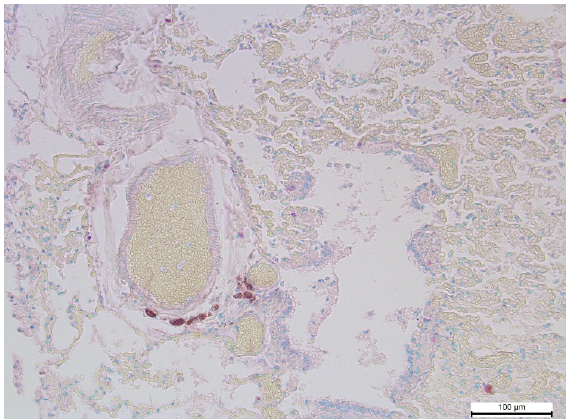
Fig. 13 B. Lungs. Single lymphocytes and macrophages in the lumen of the enlarged alveoli. Brache. EP 10, lens 20 A sharp disturbance of gas exchange in the lungs of dogs was indicated by marked changes in bronchi of different caliber. In some dogs in the middle-caliber bronchi in the lumen showed a small content of transudate. In this case, the epithelial layer of the mucous membrane is represented as a single-row cylindrical epithelium, which is mainly swollen (Fig. 14 A, B). Cell cytoplasm is often vacuolated, nuclei in a state of lysis, pycnosis, even the rejection of entire layers of the bronchial cover has been observed.